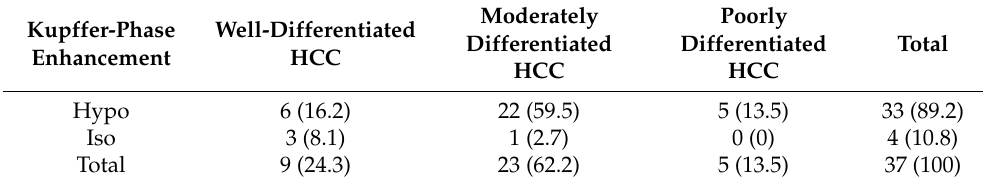
Table 7. Correlation between Kupffer-phase enhancement and hepatocellular carcinoma differentiation. Kupffer-Phase Enhancement